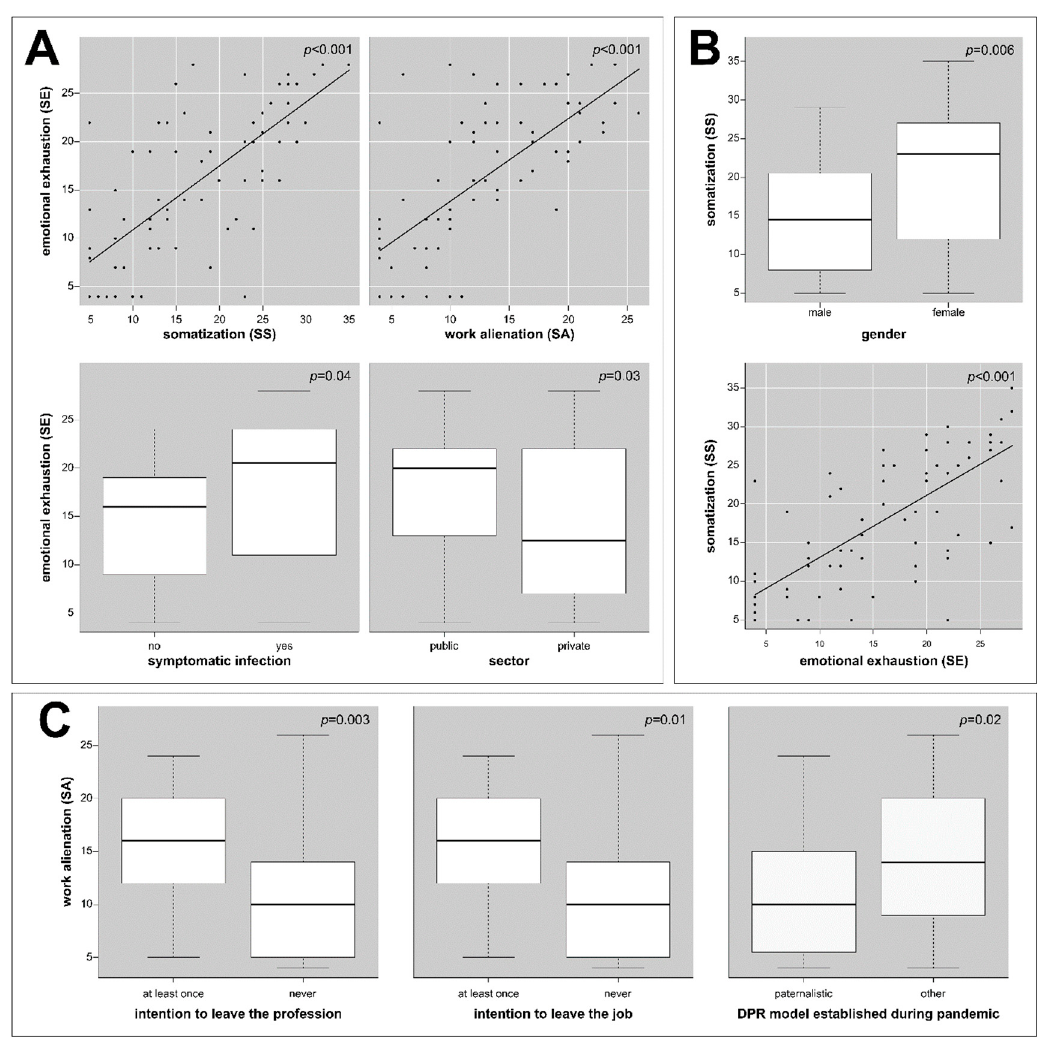
Table 3. Multiple linear regression models for somatization and emotional exhaustion measures.